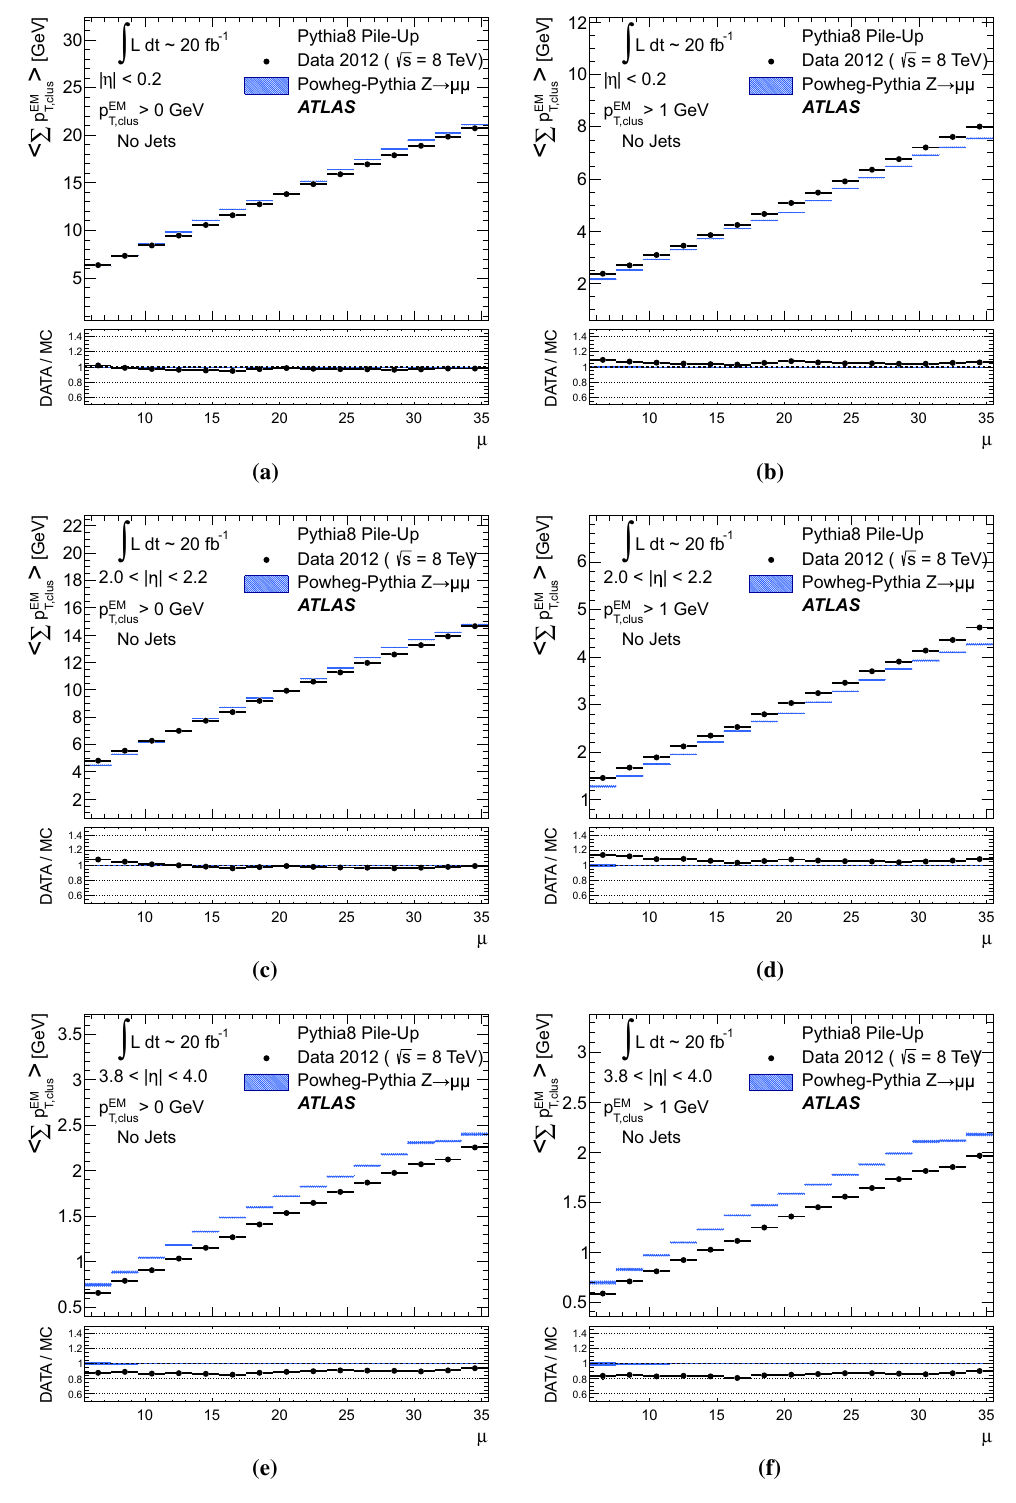
(cid:8) evaluated > 1GeV are presented in b , d , and f . Fig. 24 The average transverse momentum flow (cid:7) (cid:20) p EM using topo-clusters with p EM T , clus T , clus as function of the pile-up activity measured by the number of proton– Results are obtained from a 2012 Z → μμ sample without jets with p T > 20GeV in data and MC simulations. The narrow shaded bands protoninteractionsperbunchcrossing μ ,inseveralcalorimeterregions. (cid:8) (μ) is shown in the central ( | η | < 0 . 2), end-cap In a , c , and e , (cid:7) (cid:20) p EM around the results for MC simulations indicate statistical uncertainties, T , clus (cid:8) (μ) and the corresponding data-to-MC simulation both for (cid:7) (cid:20) p EM (2 . 0 < | η | < 2 . 2), and the forward (3 . 8 < | η | < 4 . 0) region, respec- T , clus > 0. The corresponding results tively, using topo-clusters with p EM ratios shown below each T , clus